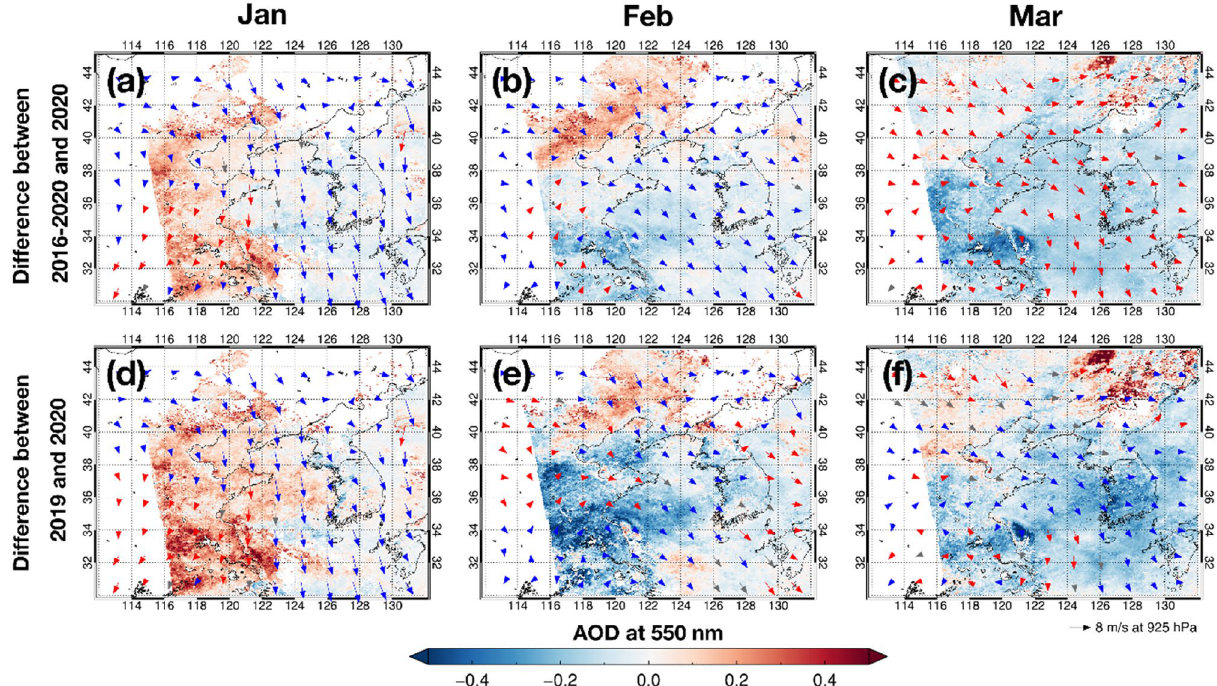
Figure 3. Differences in the ( a ) January, ( b ) February, and ( c ) March means of the GOCI AOD at 550 nm and the ERA5 wind field between 2020 and 2016–2020. ( d – f ) are same but between 2020 and 2019. The Blue color indicates the lower AOD and slower wind speed in 2020, and the red color indicates the higher AOD and faster wind speed in 2020. Figures generated with Interactive Data Language (IDL) version 8.8.0 (https ://www.l3har risge ospat ial.com/Softw are-Techn ology